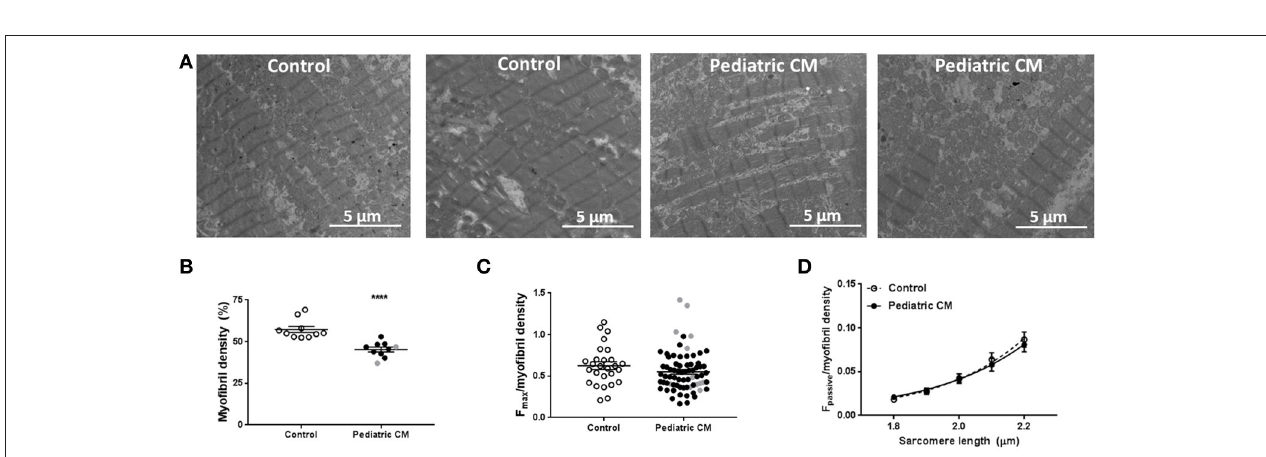
FIGURE 5 | Myofibril density is decreased in pediatric CM. (A) Electron microscopy images of 2 control samples and 2 pediatric CM samples. (B) Myofibril density was significantly lower ( P < 0.0001) in pediatric CM ( N = 10, 45.3 ± 1.4%) compared to controls ( N = 10, 57.3 ± 1.8%). (C) F max normalized for myofibril density of corresponding sample did not differ significantly between pediatric CM ( N = 10, n = 71) and controls ( N = 6, n = 27). (D) F pass normalized for myofibril density of corresponding sample was not significantly different between pediatric CM ( N = 10, n = 37) and controls ( N = 9, n = 25). N , number of samples; n , number of cardiomyocytes measured. Measurements obtained from samples derived from patients with non-compaction cardiomyopathy are indicated in gray. **** p < 0.0001 vs.